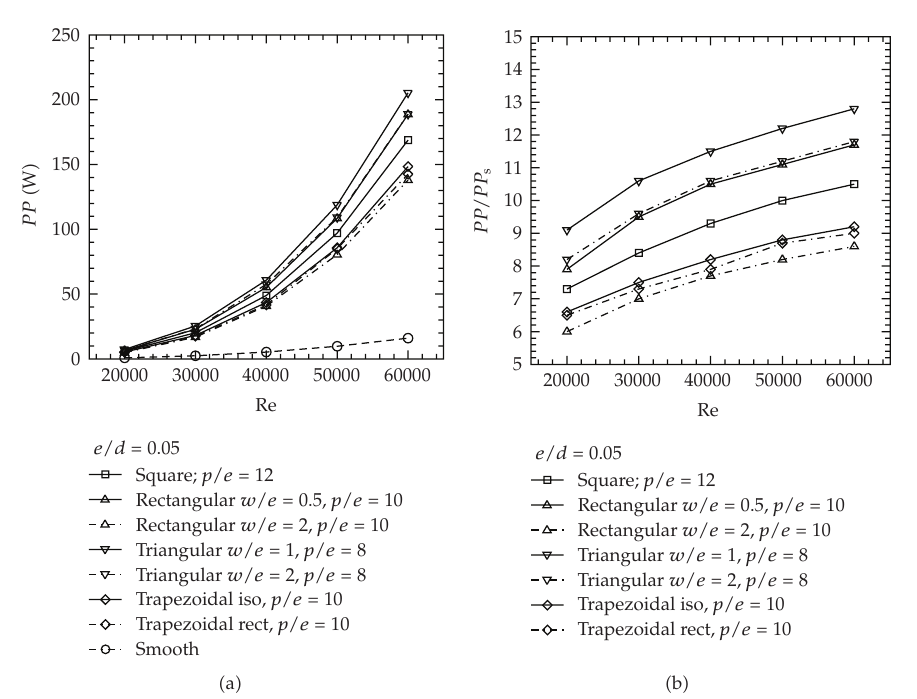
Figure 11: Profiles as a function of Reynolds numbers in the range 20000–60000 at e/d (cid:8) 0 . 05 for di ff erent rib shapes and significant pitches: (cid:6) a (cid:7) required pumping power and (cid:6) b (cid:7) pumping power referred to the smooth channel results.